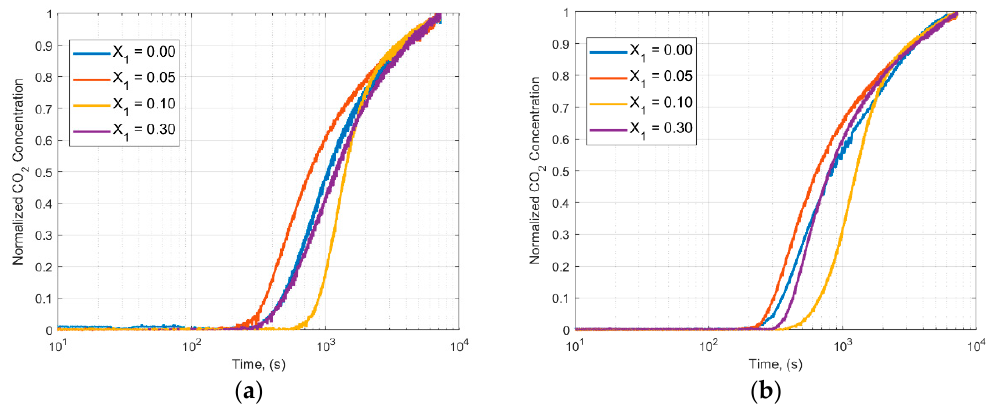
Figure 8. Effect of particle mixing on the response of the fluidized bed ( a ) Experiment 1; ( b ) Experiment 2.